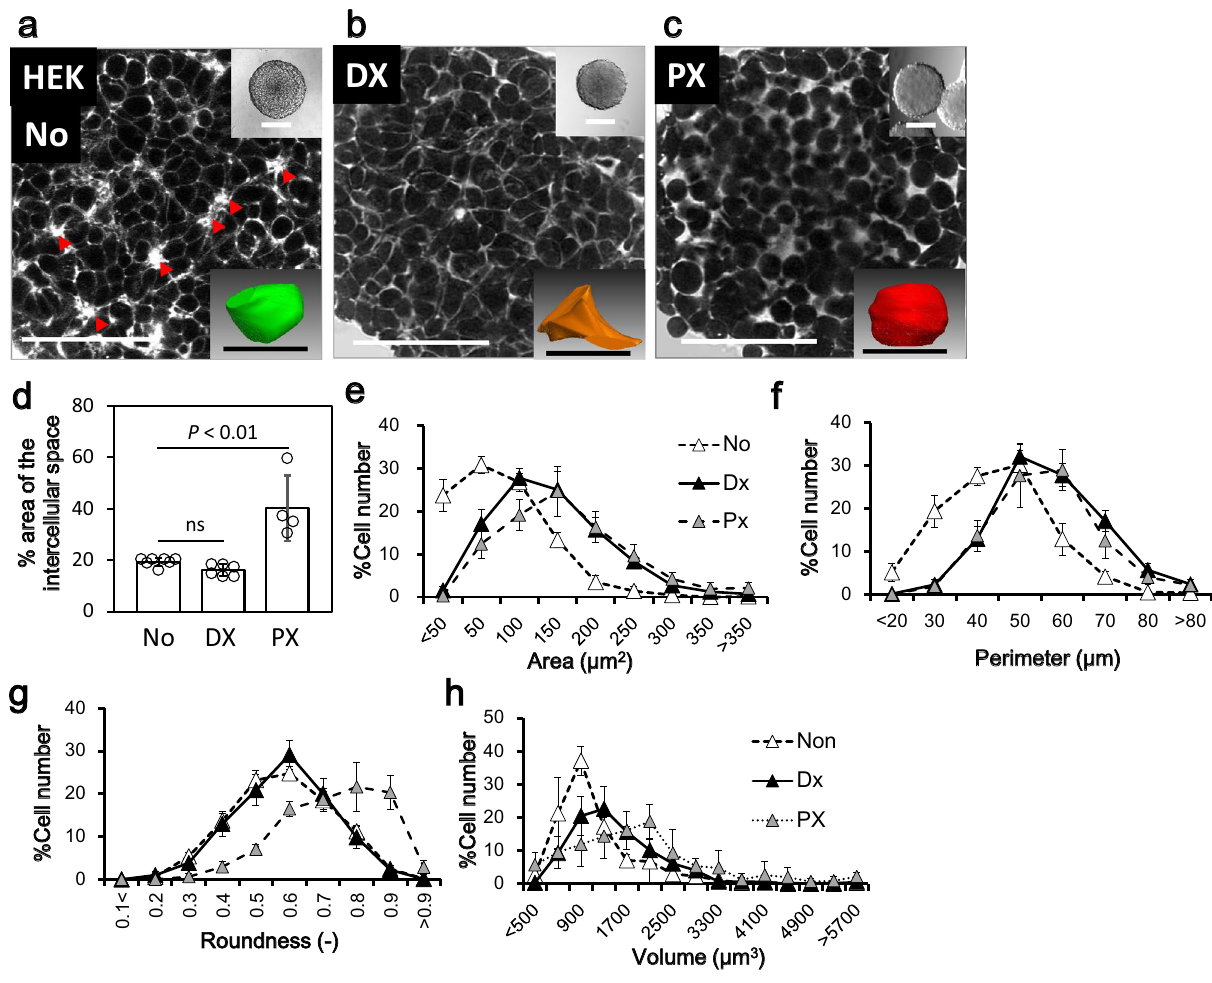
Figure 3. Structural change of HEK293T spheroid cells induced by antitumor drug treatment. ( a – c ) Representative NCI image of HEK293T day 5 spheroids without ( a ) or with overnight (18 h) treatment of doxorubicin (DX) ( b ) or paclitaxel (PX) ( c ). The drugs can be seen to make the individual cell structure and spheroid packaging either tight ( b ) or loose ( c ). Arrowheads: The characteristic Rosetta structure. Bar: 50 µm. Inset upper: Bright field. Bar: 200 µm. Inset lower: a reconstructed 3D structure of the represent cell. Bar: 10 µm. ( d ) The ratio of intercellular area to the total area of one confocal image of the spheroid. N = 7 (No); 6 (DX), 4 (PX). ( e – g ) Histograms of the individual cellular contours in the confocal image of the spheroid analyzed with the ( e ) area, ( f ) perimeter, and ( g ) roundness. N = 6. ( h ) Histograms of the volume of the individual spheroid cells located in the 50 × 50 × 100 µm of virtual area set in the center of the scanned spheroid. N =